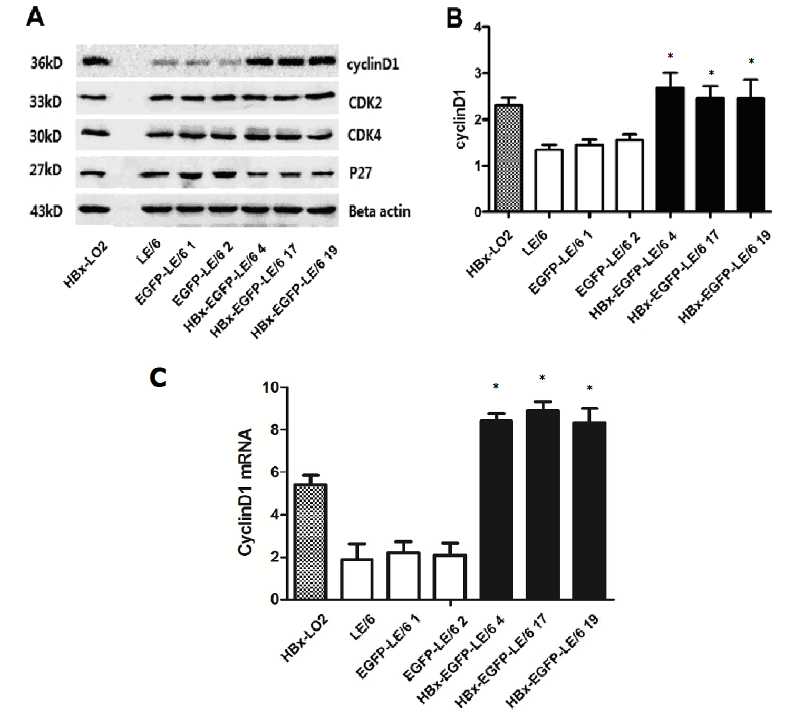
Figure 3. ( A ) Western blotting indicated that overexpression of HBx significantly increased cyclin D1 protein expression in oval cells. In contrast, expression of p27, CDK2 and CDK4 proteins were unaltered; ( B ) The bands of cyclin D1 shown in ( A ) were quantified and the band intensities are shown graphically; ( C ) qPCR results indicated that mRNA levels of cyclin D1 were remarkably increased in HBx-transfected oval cells as compared with controls. An asterisk * indicates p < 0.05 vs. LE/6 and EGFP-LE/6 controls. The data shown represent the mean ± SD of three independent